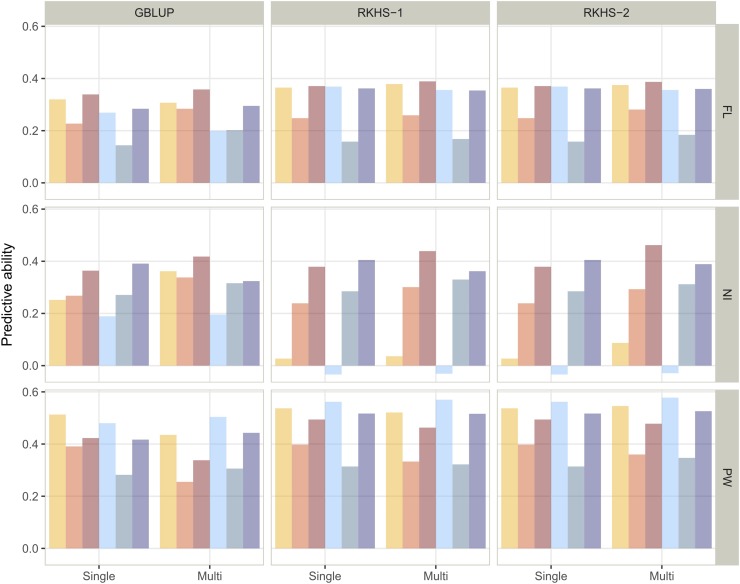
Single environment and multi-environment predictive ability in across population validation experiments obtained with three statistical models (GBLUP, RKHS-1, RKHS-2). Continuous flooding and alternate wetting and drying water management conditions are in blue and orange, respectively. The scenarios used to define the training set are represented by the different shades of orange or blue: light (S1: only the parents), intermediate (S2: 100 individuals of the RP selected with CDmean) and dark (S3: the whole RP).The three studied traits are presented: days to flowering (FL), nitrogen balance index (NI) and panicle weight (PW).